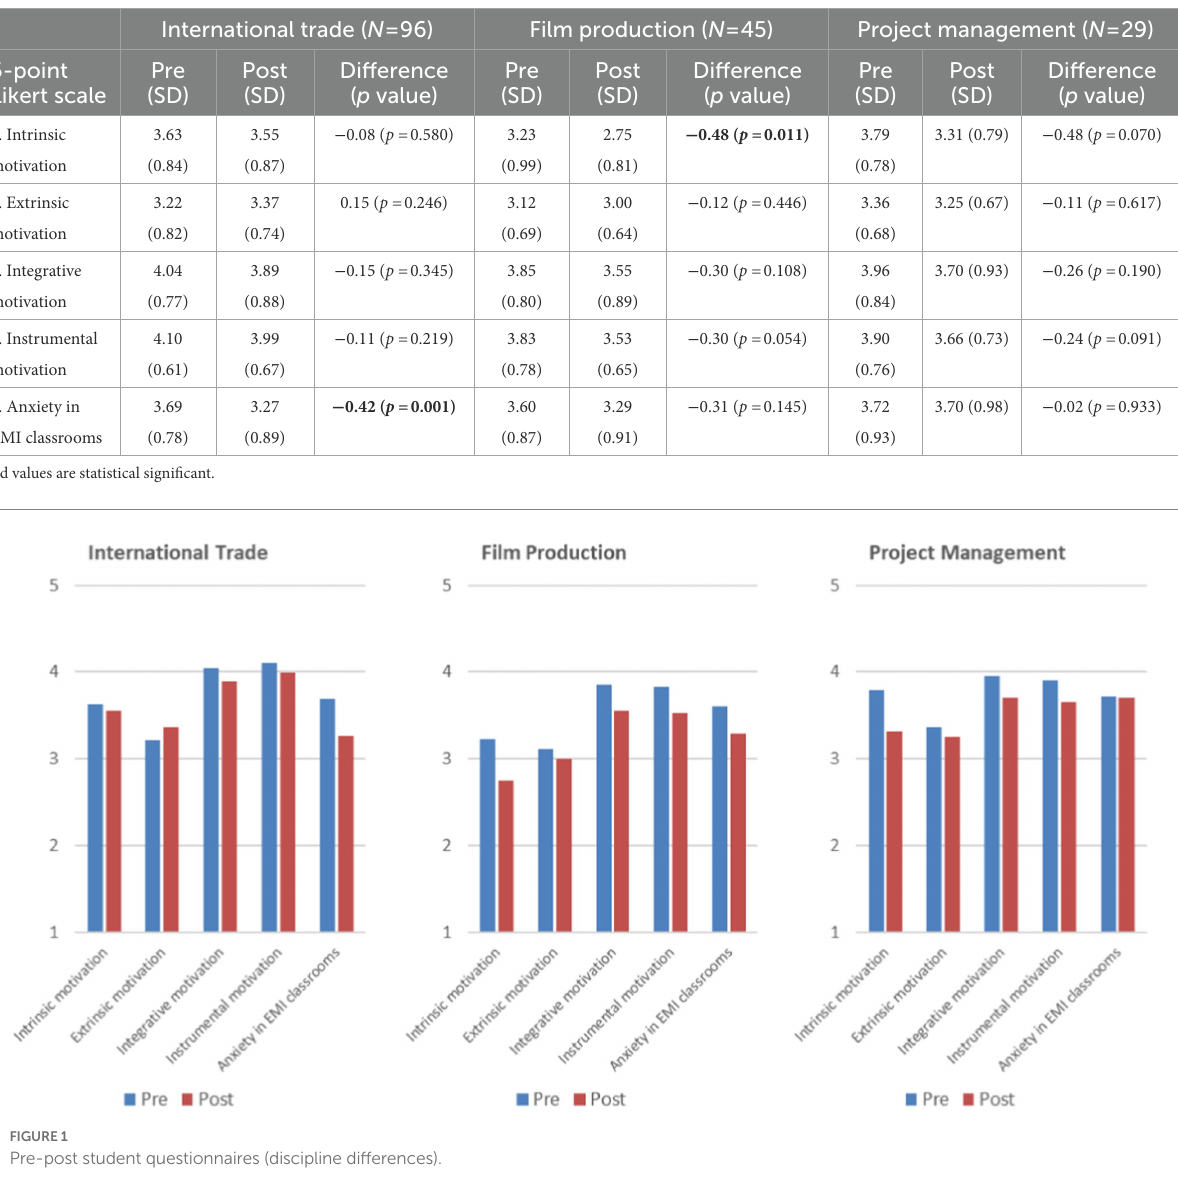
TABLE 1 Pre-post student questionnaires (discipline differences).